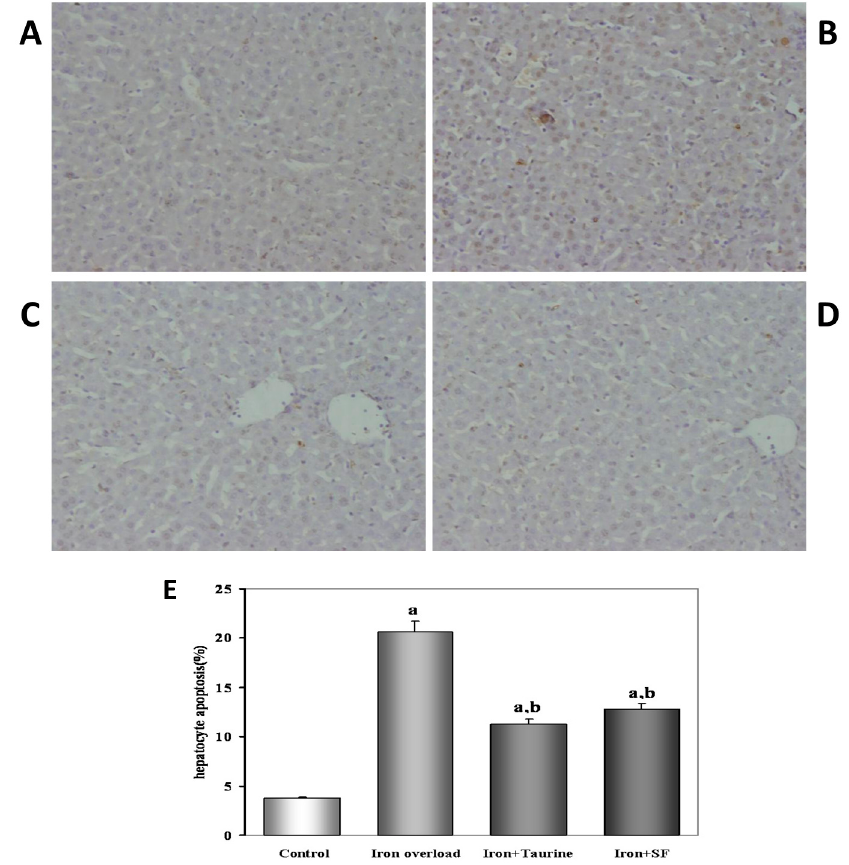
Figure 1. The effect of TAU or SF on iron overload-induced hepatocyte apoptosis. TUNEL-positive cells are identified as apoptotic, and arrowheads indicate the TUNEL-positive hepatocytes in representative photomicrographs. Original magnification is × 400. ( A ) control group; ( B ) iron overload group; ( C ) TAU-treated group; ( D ) SF-treated group ( E ) Quantitative analysis of apoptotic hepatocytes expressed as percentage of TUNEL-positive nuclei in hepatocytes. Values are mean ± SE ( n = 12). a: p < 0.01, vs. control group; b: p < 0.01, vs. iron overload group.